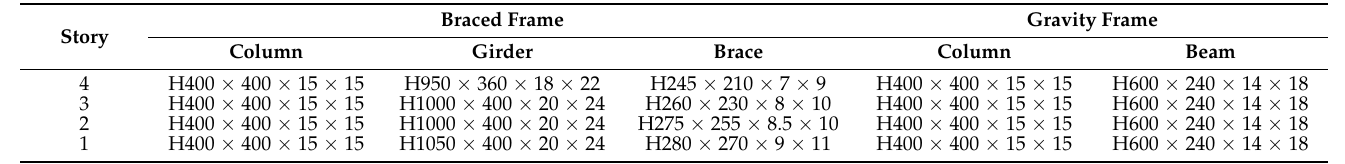
Table 1. Design-member sizes of four-story prototype (unit: mm).